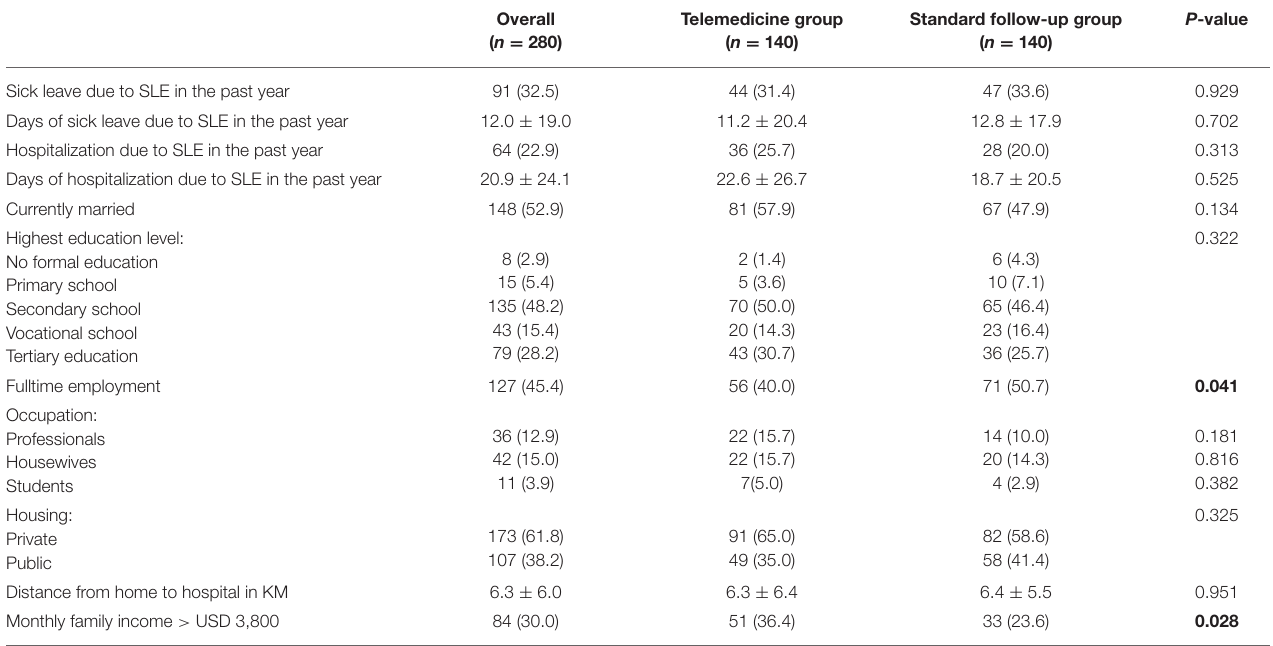
TABLE 2 | Socio-economic data of the recruited patients and comparison between the telemedicine/standard follow-up groups.